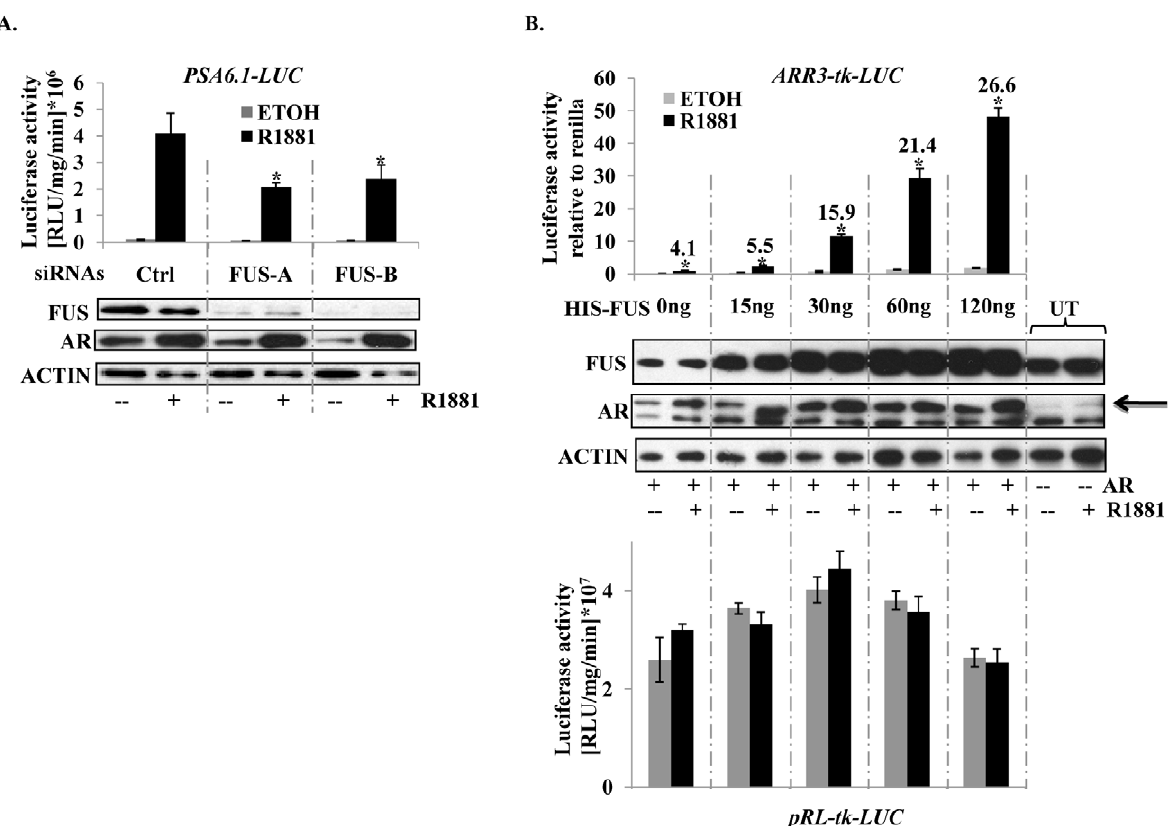
Figure 4. Levels of FUS alter AR transcriptional activity. ( A ) Depletion of FUS correlates with decreased AR activity. Levels of FUS were decreased in LNCaP cells using siRNAs targeting two different regions of the respective mRNAs and subsequently transfected with 1 ug of plasmid for PSA(6.1)-luciferase. 2 ug p-LUC empty plasmid was added to all siRNA/DNA mixes. Amounts are per well in a 6-well plate. Cells were treated with 10 nM R1881 for 24 hrs. Western blot analysis of the corresponding samples show levels of FUS, AR, and Actin. ( B ) Ectopic expression of FUS enhances AR activity. 293FT cells in a 48 well plate were transfected with 15 ng AR expression plasmid, 620 ng ARR3-tk-luciferase reporter plasmid, 62 ng renilla luciferase plasmid and indicated amounts of His-FUS expression plasmid. Luciferase activities were normalized with those from renilla luciferase that contains the minimal TK promoter. Values over each black bar represent fold-induction by R1881 after normalization (upper panel). Western blot analysis of the corresponding samples show levels of FUS, AR, and ACTIN (middle panel). UT: untransfected cells. Renilla luciferase activity from the same samples normalized to total protein served as a specificity control (lower panel). Columns=mean 6 standard deviation. *P , 0.05,